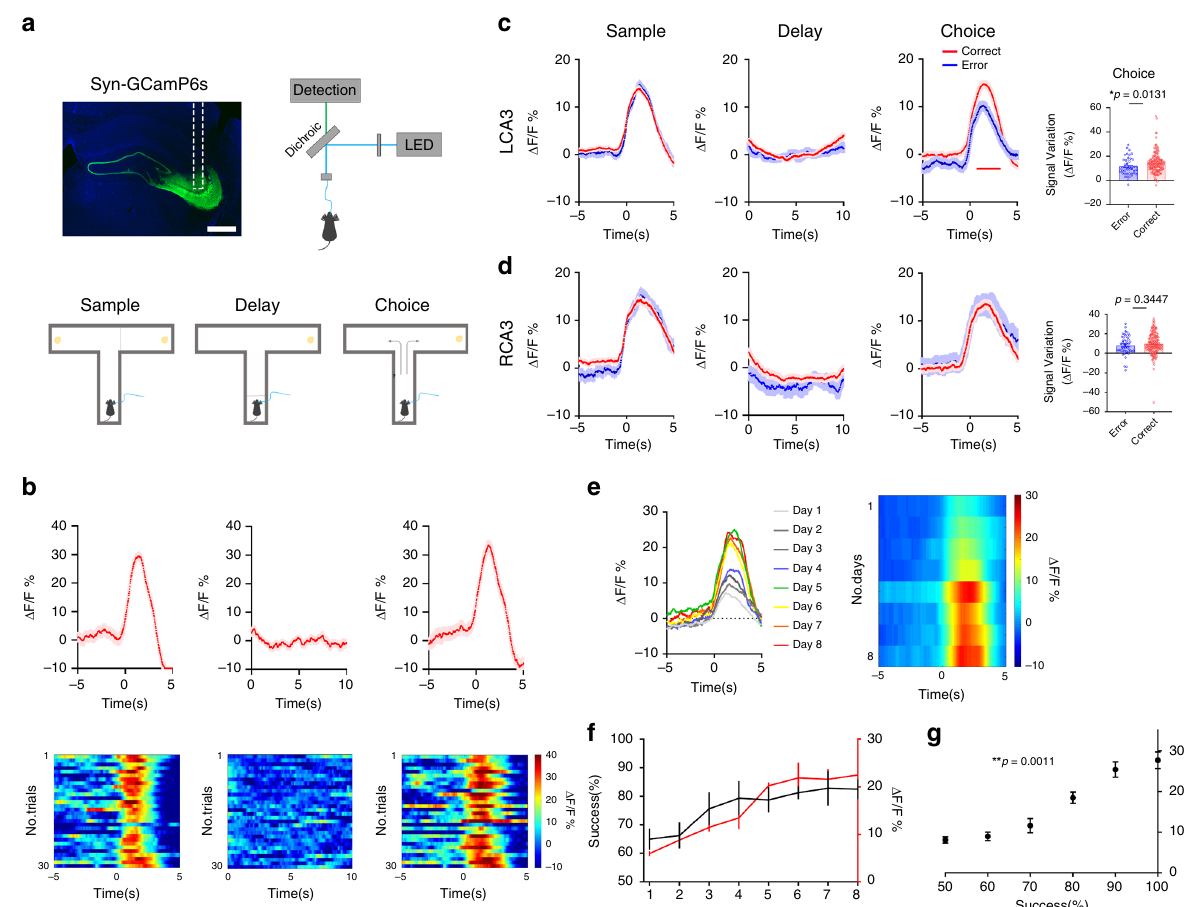
Fig. 1 LCA3 neurons show higher amplitude of increased activity in T-maze task. a Schematic of fi ber photometry recording in T-maze task. Scale bar: 200 μ m. b The mean and SEM of an example of corresponding Ca 2 + signal in CA3 region of a well-trained mouse at the sample, delay and choice phases. CA3 neurons were activated during the sample and choice phases, while remained unchanged during the delay phase. c The mean and SEM of Ca 2 + signal between the correct and error trials in LCA3 neurons at the sample, delay and choice phases from eight mice. The amplitude of increased signals in the correct trials was signi fi cantly higher than that in the error trials as mice initiated to run in the choice phase. Red line indicated bins between the correct and error trials with two-tailed unpaired t-test signi fi cance ( P < 0.05). Right: quanti fi cation of the average amplitude of increased signal against baseline between the correct and error trials in LCA3 at the choice phase (error: n = 49 trials; correct: n = 160 trials; unpaired two-tailed Mann – Whitney-U-test, * p = 0.0131). d The mean and SEM of Ca 2 + signal between the correct and error trials in RCA3 neurons at the sample, delay and choice phases from six mice. The amplitude of increased signal had no differences between the correct and error trials in RCA3 in the choice phase. Right: quanti fi cation of the average amplitude of increased signal against baseline between the correct and error trials in LCA3 at the choice phase (error: n = 47 trials; correct: n = 169 trials; unpaired two-tailed Mann – Whitney-U-test, p = 0.3447). e The mean and SEM of Ca 2 + signal among 8 days and their corresponding heatmap. The amplitude of Ca 2 + signal was increased within processed days and reached a plateau after 5 days of training. f Plot of the amplitude of Ca 2 + signal and their corresponding success rates. g The correlation between SWM task performance and the amplitudes of Ca 2 + signal (two-tailed Pearson (R) correlation, ** p = 0.0011, r = 0.9726). Data are presented as mean ± SEM ( c and d right panels, f , g ). Source data are provided as a Source Data fi